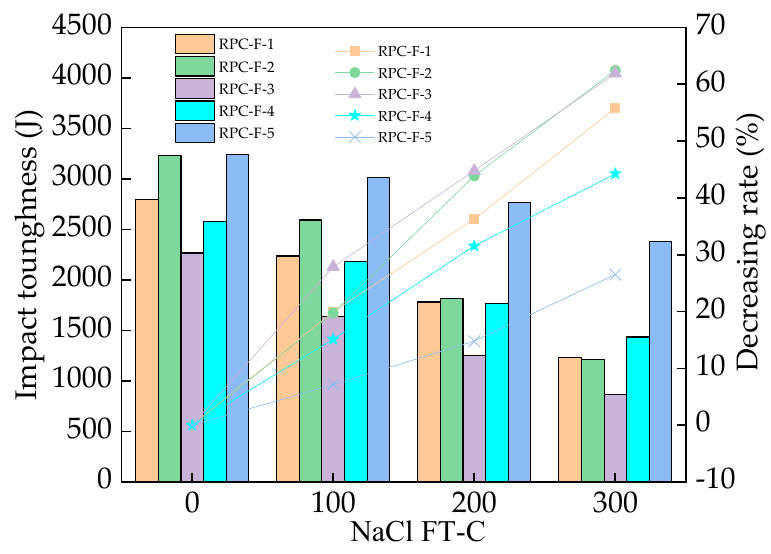
Figure 8. The impact toughness of RPC during NaCl